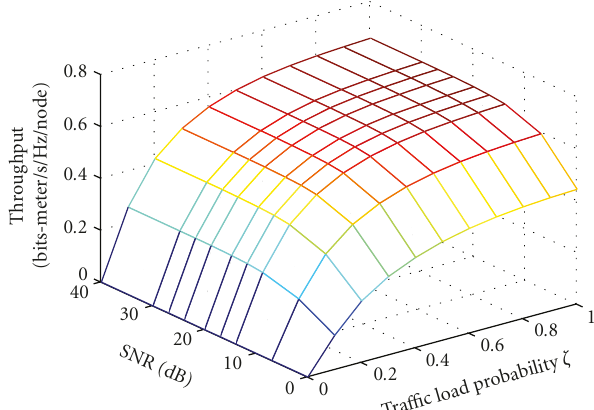
Figure 5: Throughput of O-SAM versus load probability ζ and SNR. We used ρ = 1, square topology, and SISO channels.